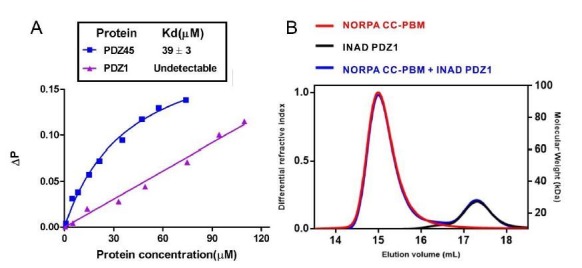
Binding analysis of INAD PDZ1 to NORPA PBM and NORPA CC-PBM.(A) Fluorescence polarization assay showed that no interaction could be detected between NORPA PBM peptide (TQGKTEFYA) and INAD PDZ1. As a control, FITC-labeled NORPA PBM peptide bound to INAD PDZ45 with a Kd ~ 40 μM. (B) FPLC analysis showed INAD PDZ1 does not interact with NORPA CC-PBM.